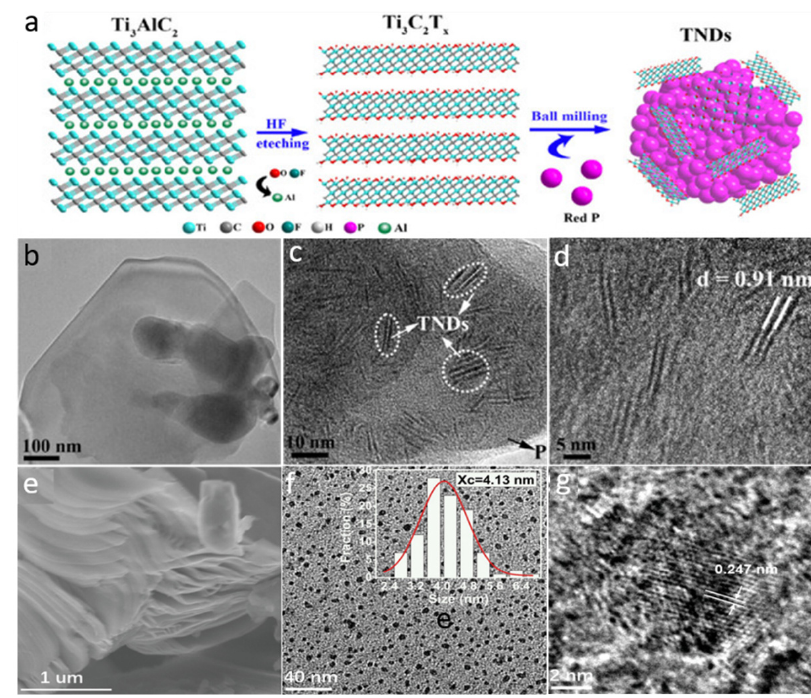
Figure 6. ( a ) Schematic of the synthesis process, and ( b – d ) FE-TEM micrographs of the Ti 3 C 2 T x nanodots. ( e ) The SEM micrograph of V2C MXene. ( f ) The average size of the generated V2C MXene was 4.13 nm, and it was 2.33 nm thick. ( g ) The lattice fringes with d-spacing of 0.247 nm. Reproduced with permission from ref. [67] Copyright 2017, The Willey.